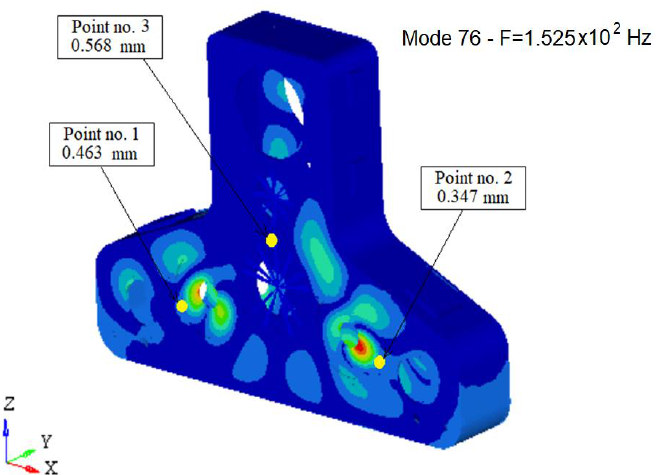
Figure 14. Displacements of the points on the front surface of the housing for mode 76.